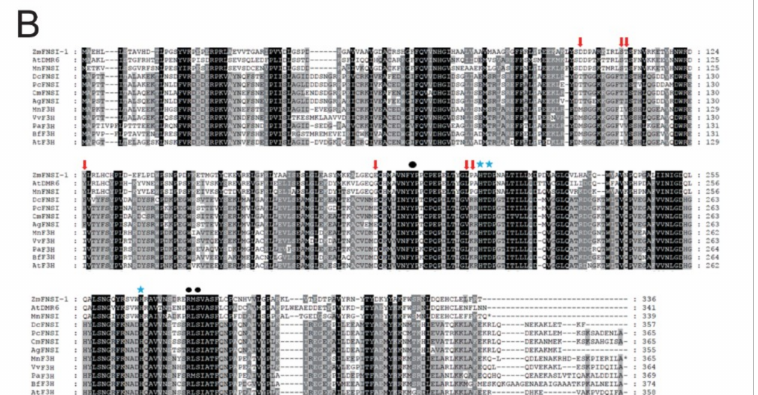
Figure 2. Sequence alignment and phylogenetic analysis of Fe 2 + / 2-oxoglutarate-dependent dioxygenases involved in flavonoid biosynthesis. ( A ) Phylogenetic tree constructed with aligned protein sequences with MEGA 5 using the neighbor-joining method with 1000 bootstrap replications. Di ff erent Fe 2 + / 2-oxoglutarate-dependent dioxygenases are grouped in clusters according to their main demonstrated activities. ( B ) Comparison of MnFNSI proteins with other FNSI and F3H proteins. Red arrow indicates sites determining catalytic activity of FNSI. Asterisks and black dots indicate conserved amino acids necessary for cofactor or substrate binding,